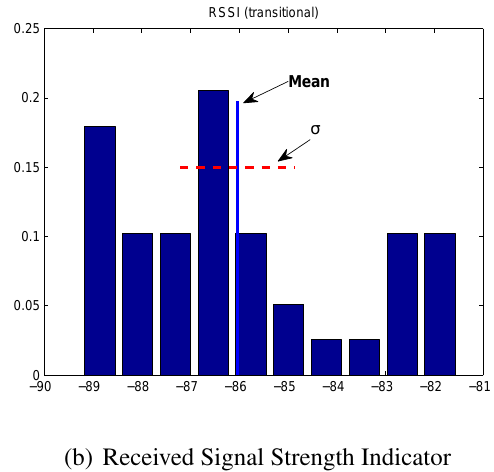
Figure 5. PER and RSSI histogram for the transitional region. Corridor